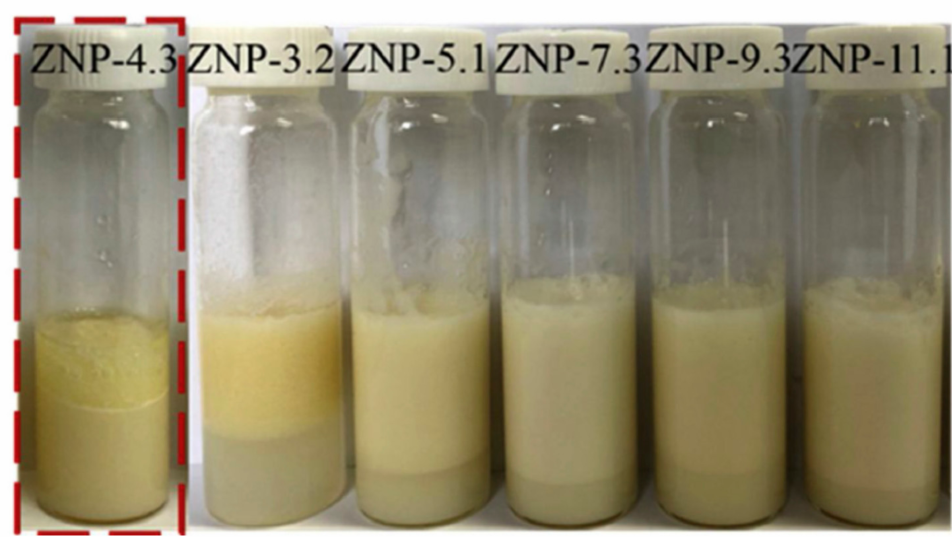
Figure 3. Pickering emulsions containing zein nanoparticles prepared after treating with alkaline pH showed substantially increased stability even after 28 days of storage. Reprinted with permission from ref. [16]. Copyright 2020